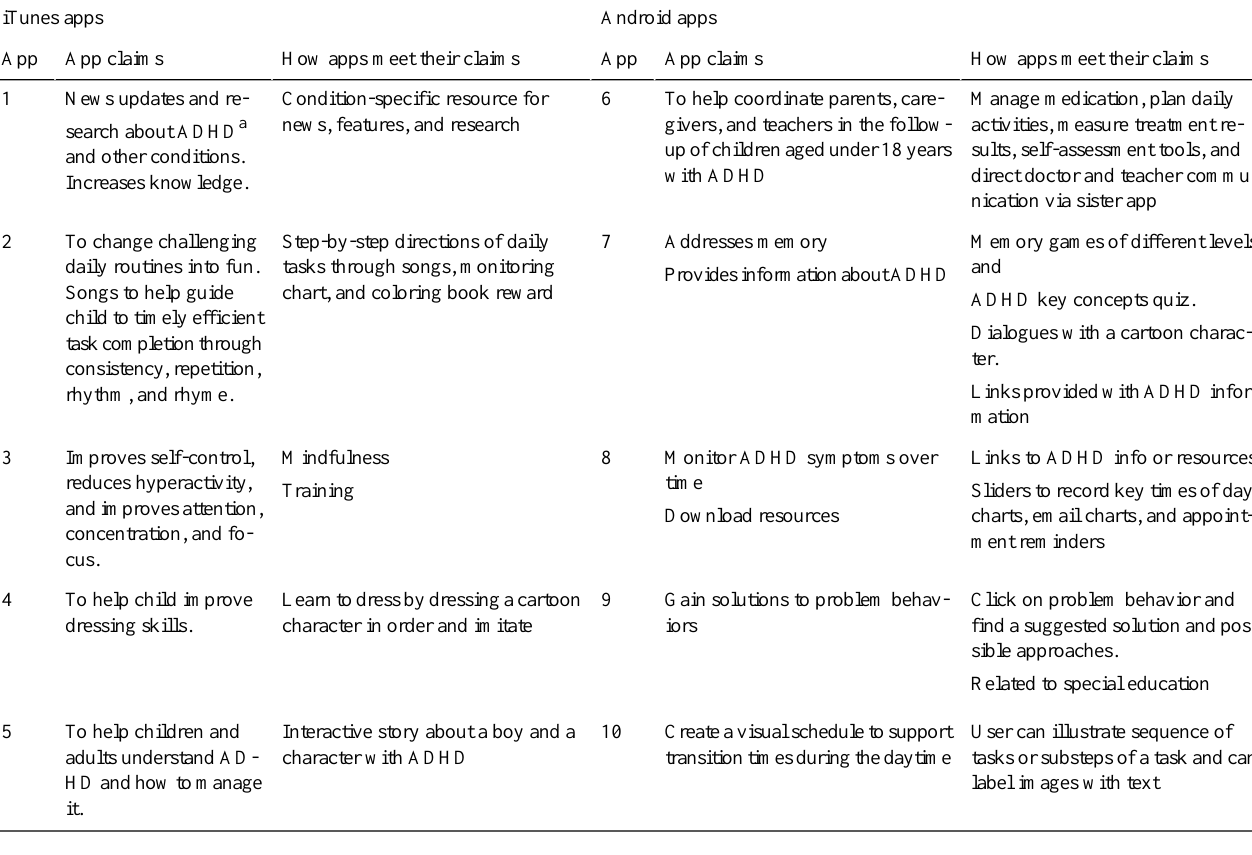
Table 1. Summary of how app developers describe the features of their apps.